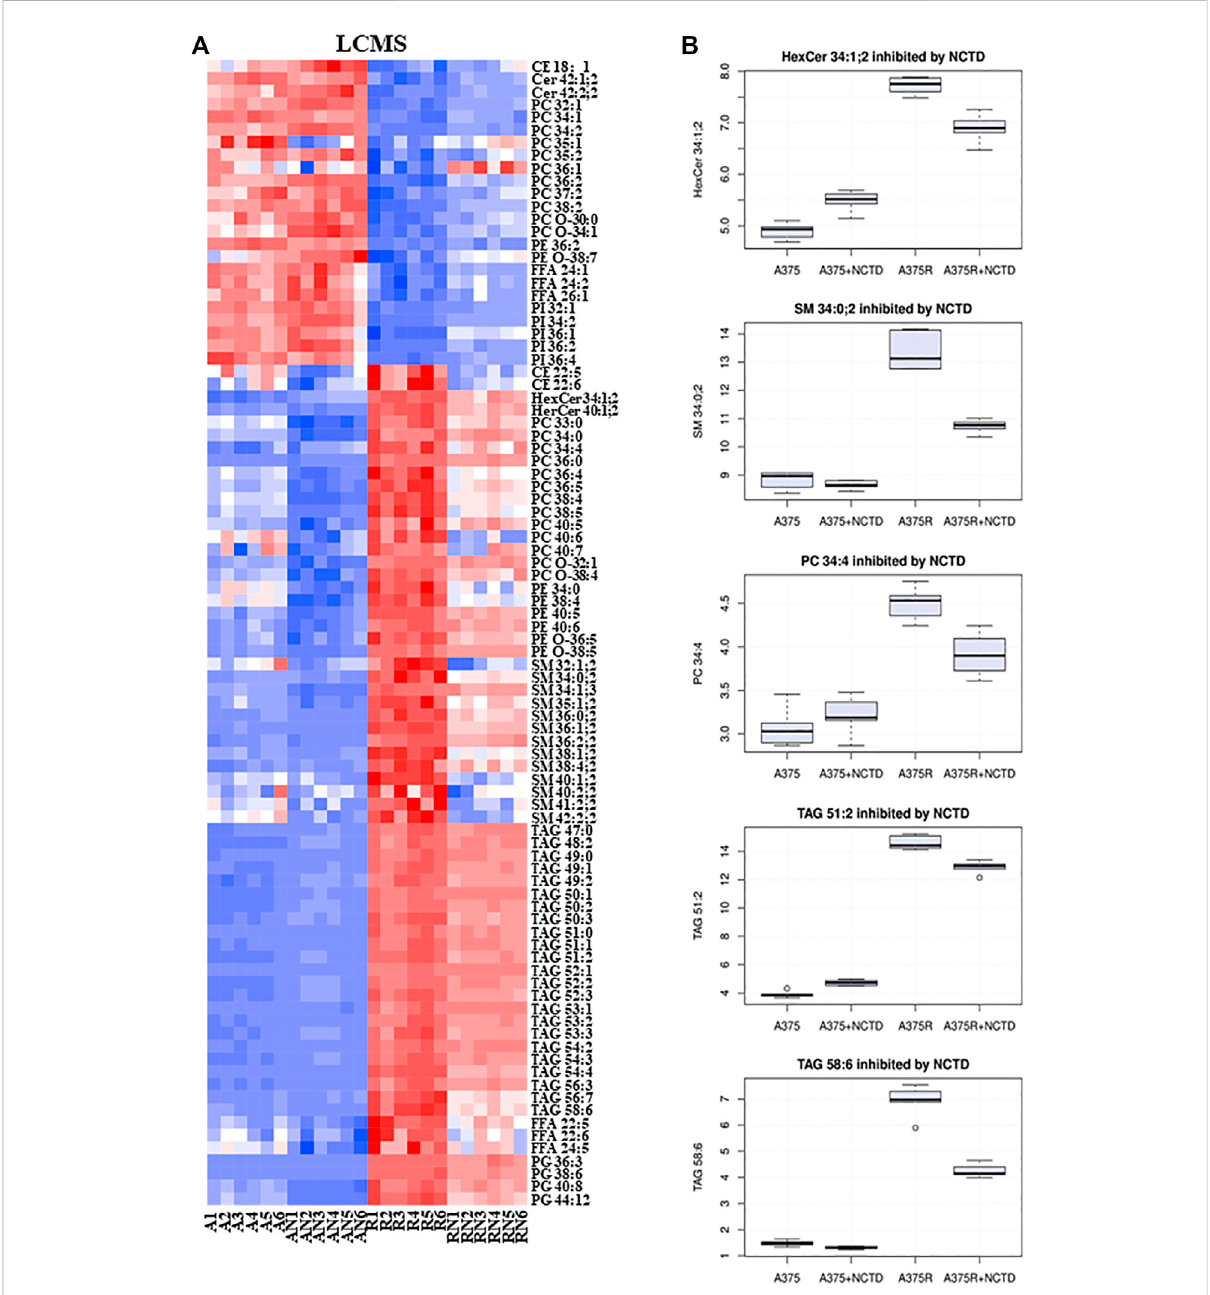
FIGURE 5 NCTDtargetedVem-inducedlipidalterations basedontheLC-MSmetabolomicsanalysis. (A) Heatmapofsigni fi cantly changedlipidsbasedon LC-MS in the A375, A375R, A375 + NCTD, and A375R + NCTD samples. Red in the heatmap represents the upregulated lipids, and blue represents downregulated lipids. (B) Some histograms showed statistically signi fi cantly downregulated lipids in A375R